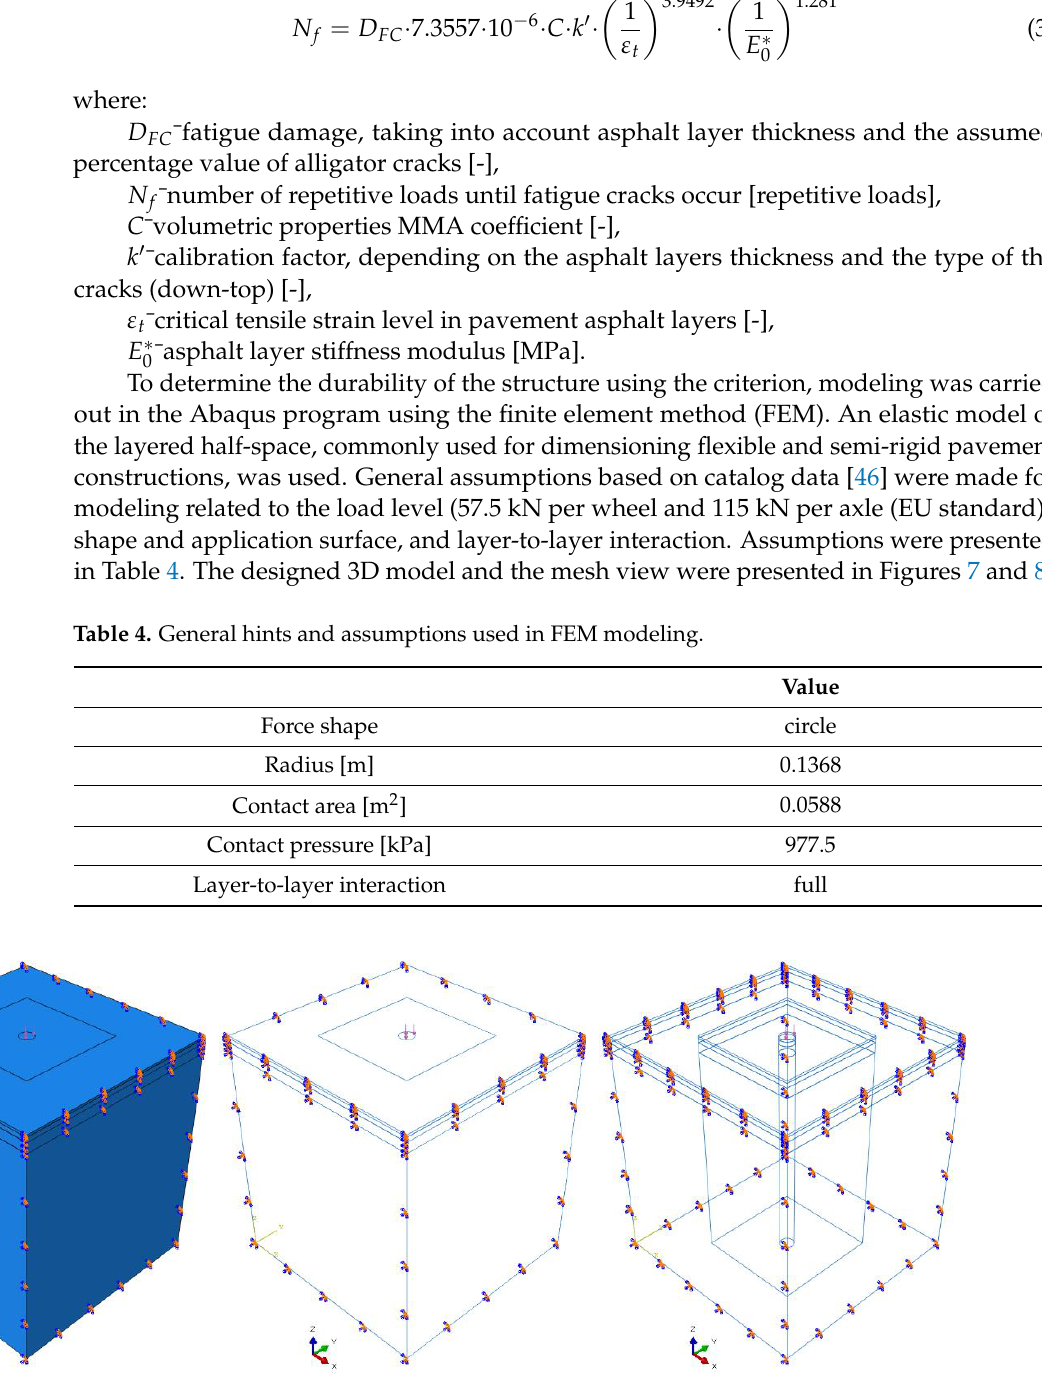
Figure 7. Model 3D in Abaqus.